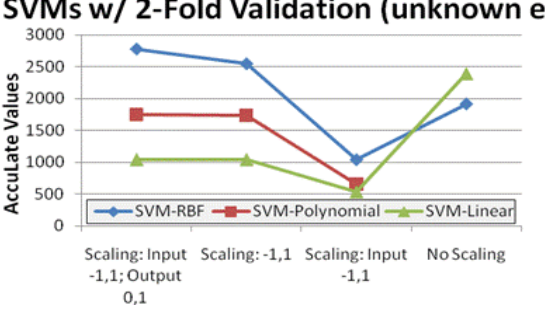
Fig. 10: SVM AccuLate Values for Unknown